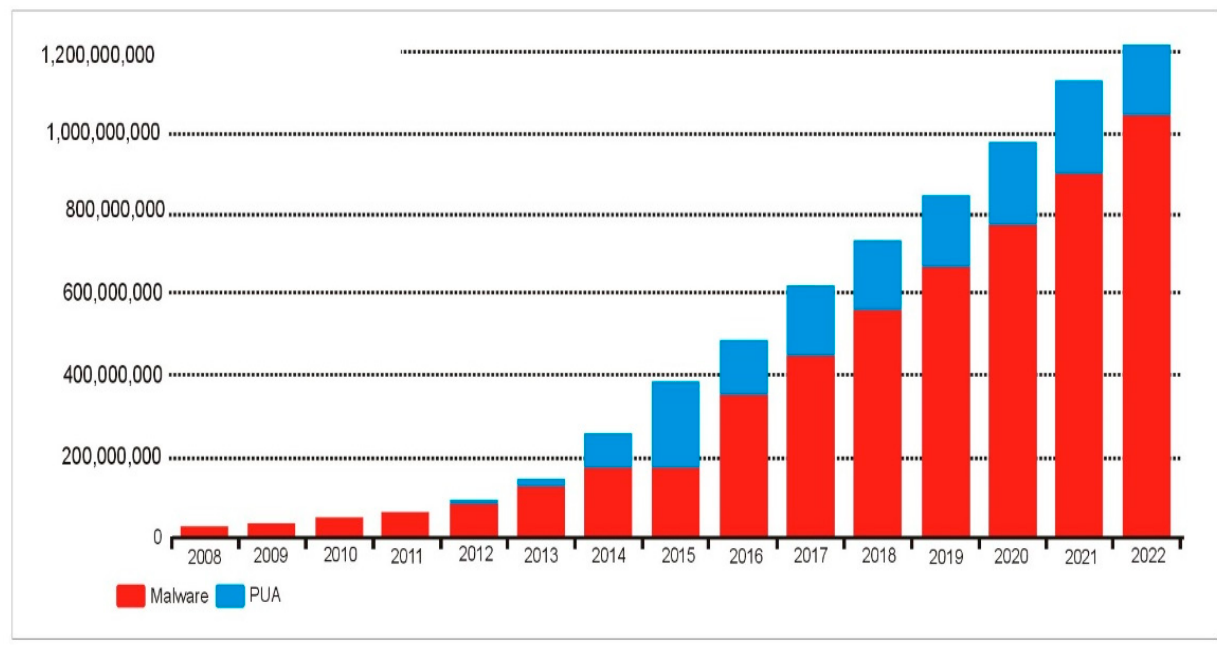
Figure 3. Total amounts of malware and potentially unwanted applications (PUAs).